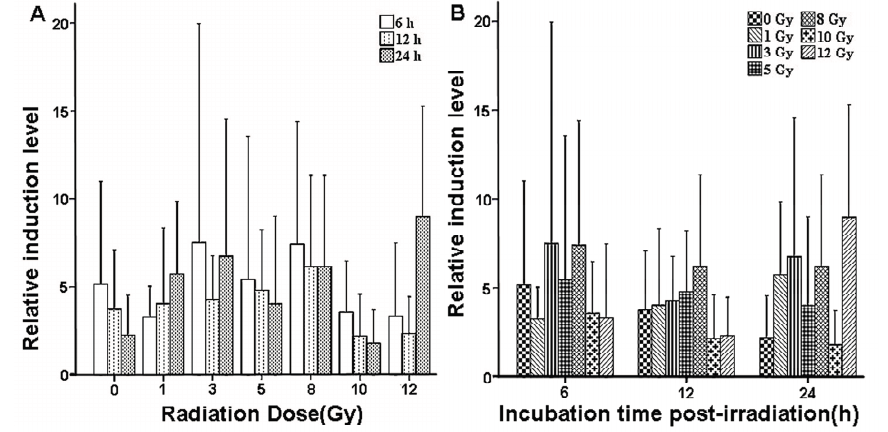
Figure 4. Expression of CCL2 in human peripheral blood after X-ray irradiation. ( A ) Dose-dependent expression change; and ( B ) time-dependent expression change. Error bars represent standard deviation ( n = 7